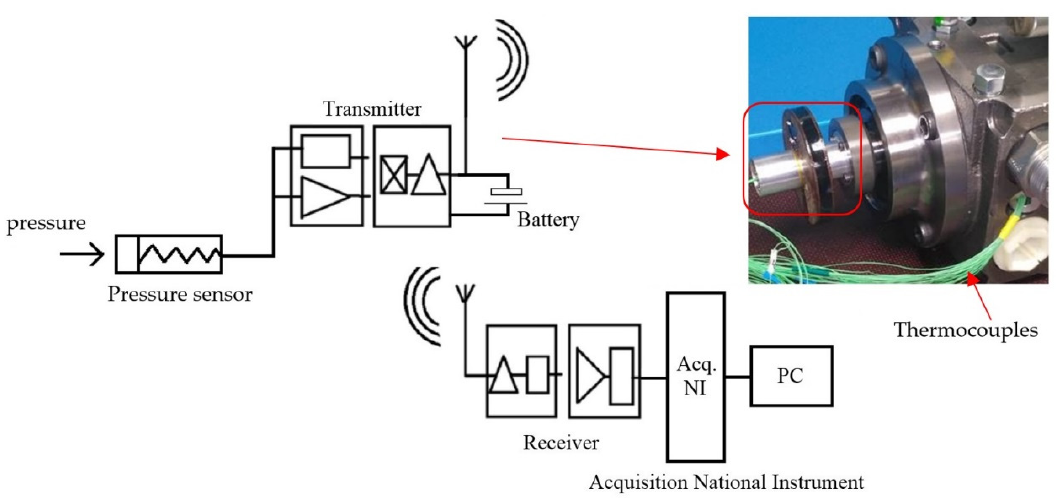
Figure 7. The principle schema of telemetry system and its installation on the pump.